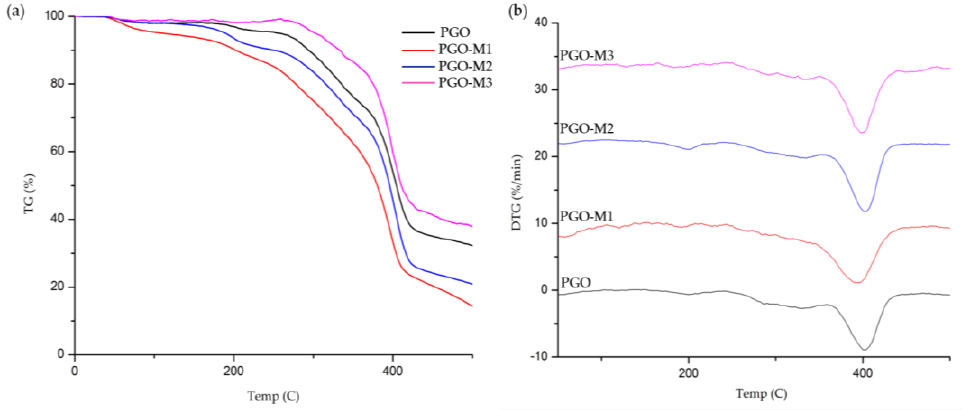
Figure 7. ( a ) TGA and ( b ) DTG of functionalized nanofibers.